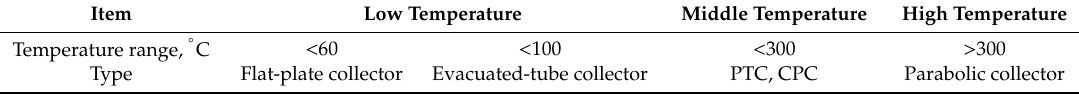
Table 3. Classification of solar collectors according to temperature level [70]; 2017, WorldSciNet.